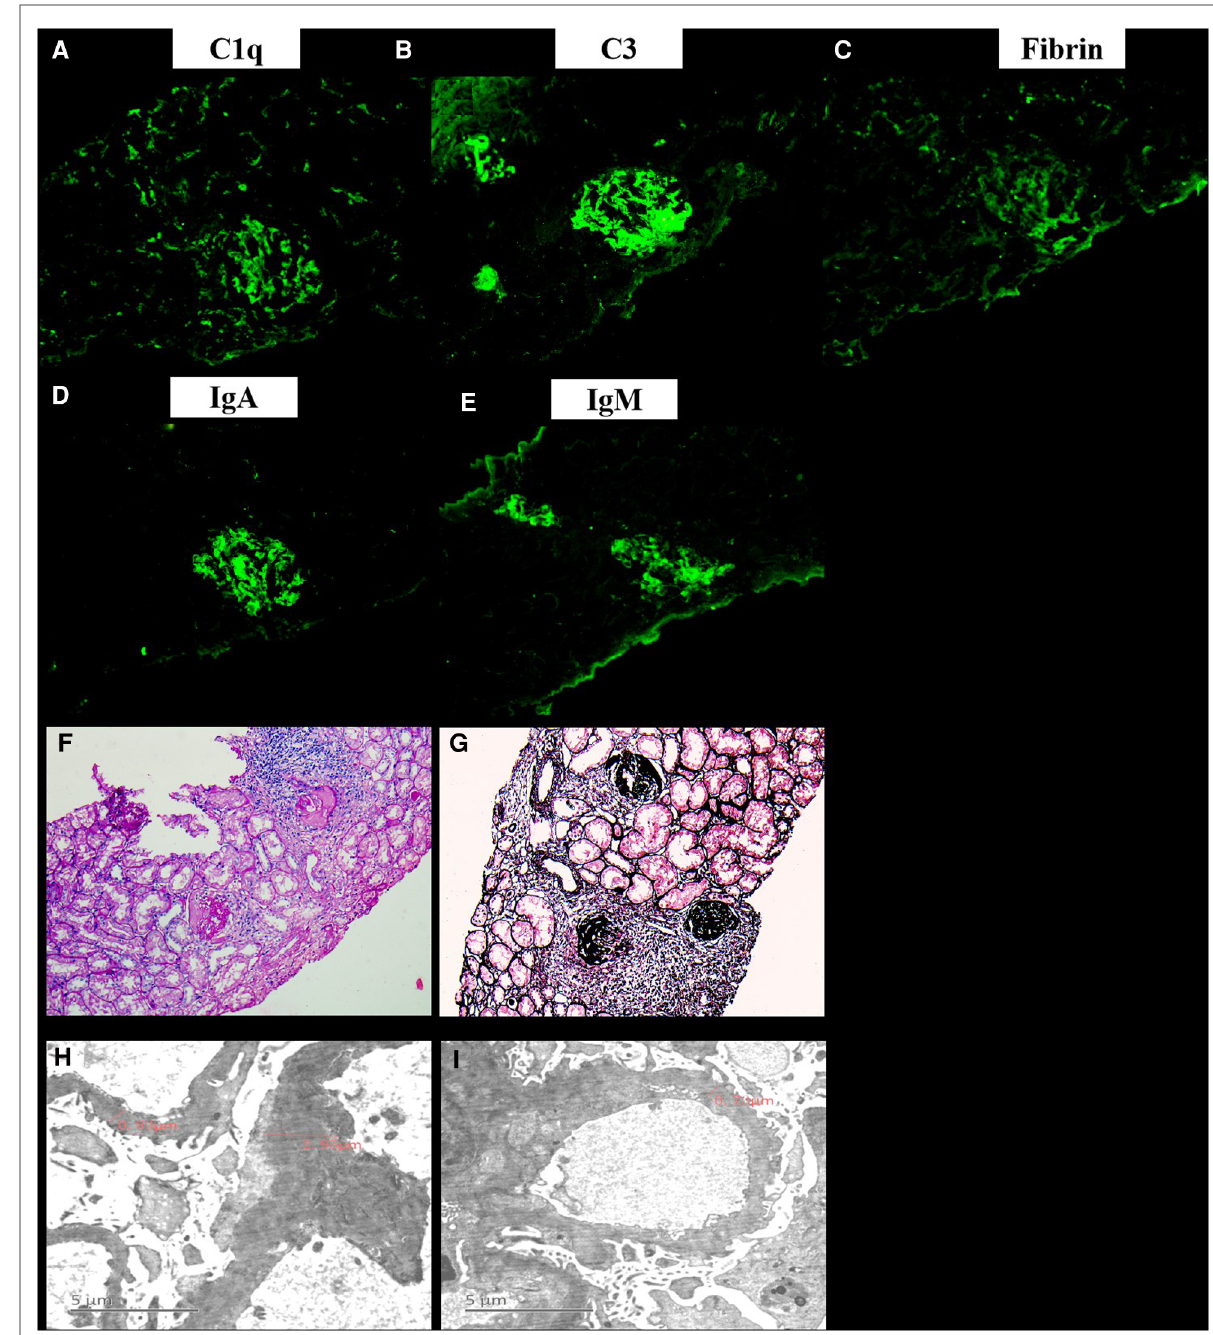
FIGURE 3 The renal pathology of the current patient. Immuno fl uorescence showed that IgA, IgG, C3, IgM, Fibrin, C4, C1q, MAB α -1, MAB α -3, and MAB α -5 were all positive ( A-E ). Under the light microscope, there were 11 glomeruli, 9/11 glomeruli had bulbous sclerosis, the other 2 glomeruli had increased lobulation, mesangial cells (2 – 4 area) hyperplasia and mesangial matrix, capillaries did not open well, and endothelial proliferation and glomerulus exudation with peribulbar fi brosis and in fl ammatory cell in fi ltration were observed. Segmental thickening of the glomerular basement membrane was found, and deposition of polyerythrophilin was observed subcutaneously in the mesangial area. Additionally, there were vacuolar degeneration of renal tubules, abundant protein tubules, and marked edema and fi brosis of renal interstitium with focal in fl ammatory cell in fi ltration ( F-G ). The mesangial cells in 2 glomeruli showed mild to moderate proliferation of matrix with abundant electron deposits. Capillary basement membrane thickness extensively thickened (800 – 3000 nm). There were large high-density electron deposits on the endothelial side, extensive fusion of microvilli, and partial renal tubular epithelial edema in the foot process ( H-I